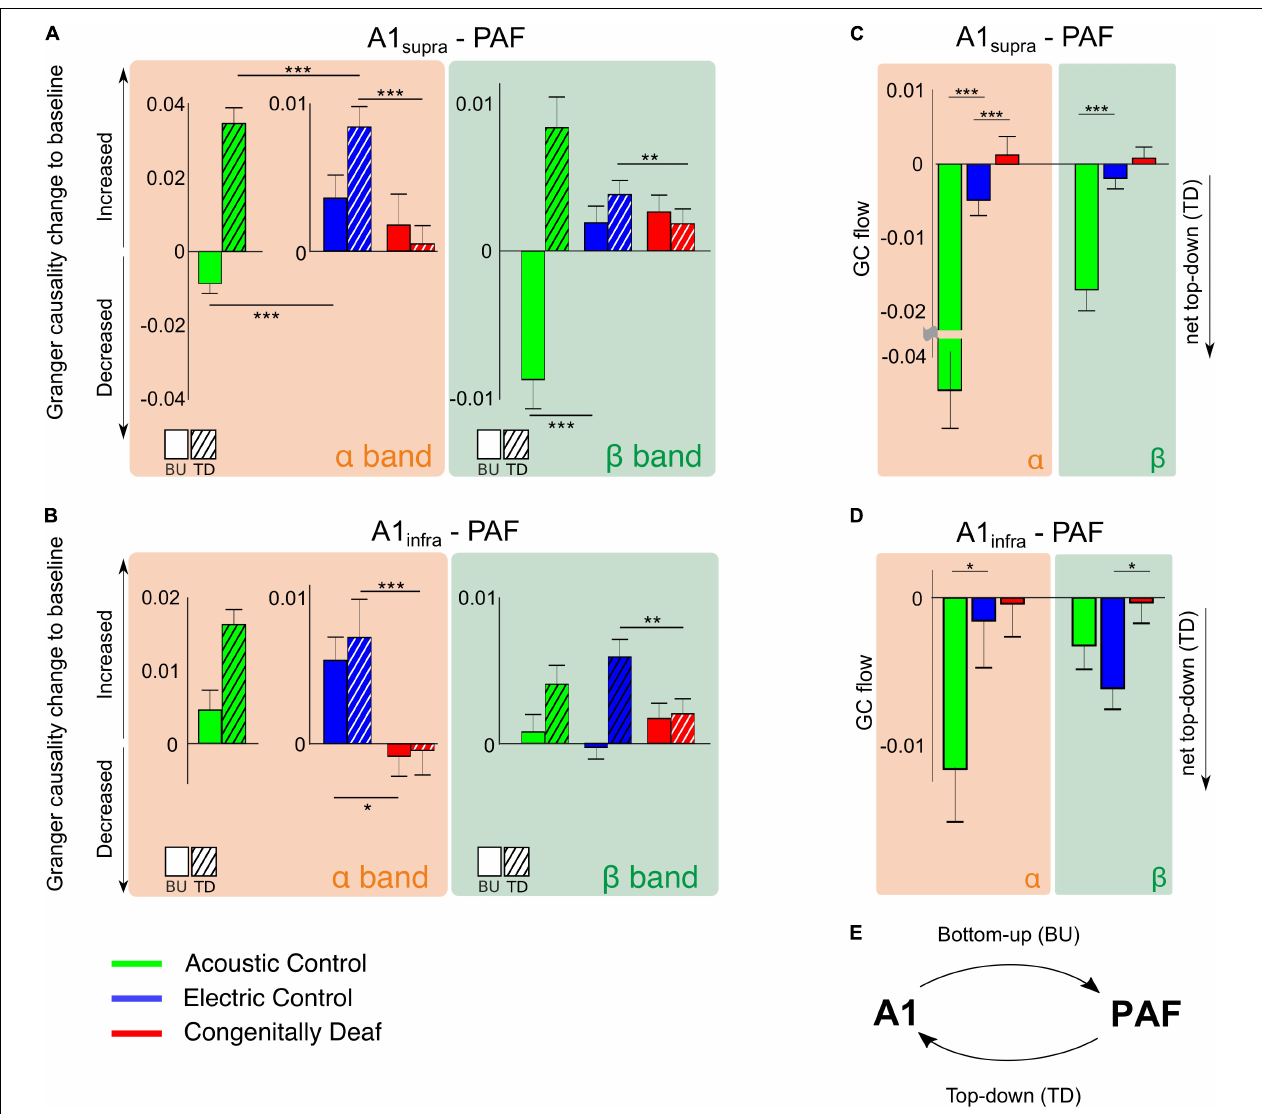
FIGURE 6 | Stimulus-related effective connectivity difference across groups. (A,B) Bar plots of alpha and beta band effective connectivity for A1 supra – PAF (A) and A1 infra – PAF (B) couplings for all three groups in the late window. Bottom-up (BU) represents connectivity from A1 to PAF while top–down (TD) represents connectivity from PAF to A1. Data shown represent Granger causality (GC) change to baseline (poststimulus GC minus baseline GC). Positive (negative) values indicate increased (decreased) effective connectivity relative to baseline. Solid bars are bottom–up interactions, hatched bars represent top-down interactions. (C,D) Barplots of alpha- and beta-band GC flow for A1 supra – PAF (C) and A1 infra – PAF (D) couplings for three groups. Data shown are GC flow change to baseline (poststimulus GC flow minus baseline GC flow). GC flow was computed as bottom–up GC minus top–down GC; positive (negative) GC flow values represent domination of bottom–up (top–down) connectivity. Bar plot colors: acoustic control (green), electric control (blue), and congenitally deaf (red) groups. Group pair comparisons were computed using the two-tailed Wilcoxon rank-sum test. * P < 0.05; ** P < 0.01; *** P < 0.001. (E) Illustration of bottom–up (BU) connectivity from A1 to PAF and top–down (TD) connectivity from PAF to